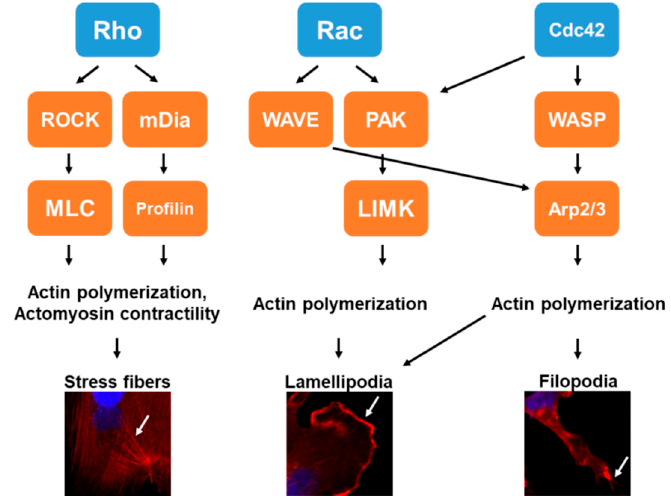
Figure 1. Actin-based structures driven by Rho, Rac and Cdc42 Rho GTPases. General mechanisms and representative images of MDA-MB-231 LM2 breast cancer cells stained with phalloidin (red) and DAPI (4 ′ ,6-diamidino-2-phenylindole) (blue) showing the formation of stress fibers (Rho, arrow), lamellipodia (Rac, arrow) and filopodia (Cdc42, arrow) formation. Abbreviations: LIMK, LIM domain kinase; mDia, mammalian diaphanous homolog; MLC, myosin light chain; PAK, p21 (RAC)-activated kinase; ROCK, Rho-associated, coiled-coil-containing protein kinase; WASP, Wiskott-Aldrich syndrome protein; WAVE, WASP family member.